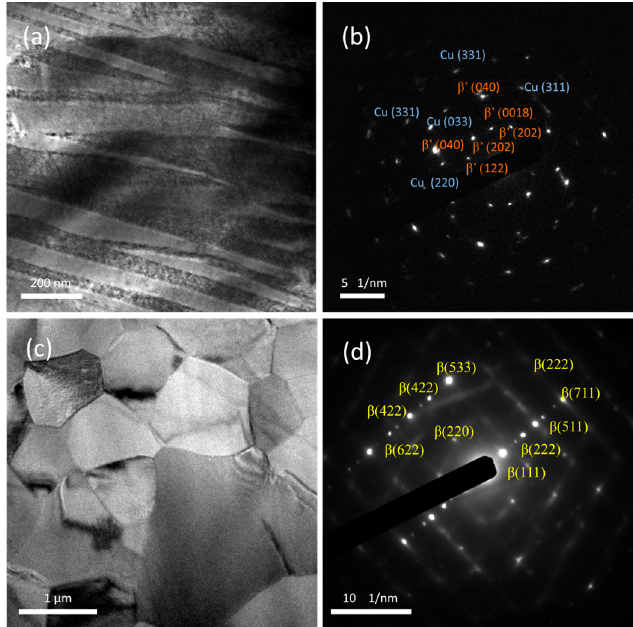
Figure 3. ( a ) Transmission electron microscopy (TEM) image of Cu–14Al–4Ni (wt.%) thin film produced from multilayer deposition followed by annealing; ( b ) SAED pattern of ( a , c ) TEM image of Cu–12Al–7Ni (wt.%) thin film; ( d ) SAED pattern of ( c ).